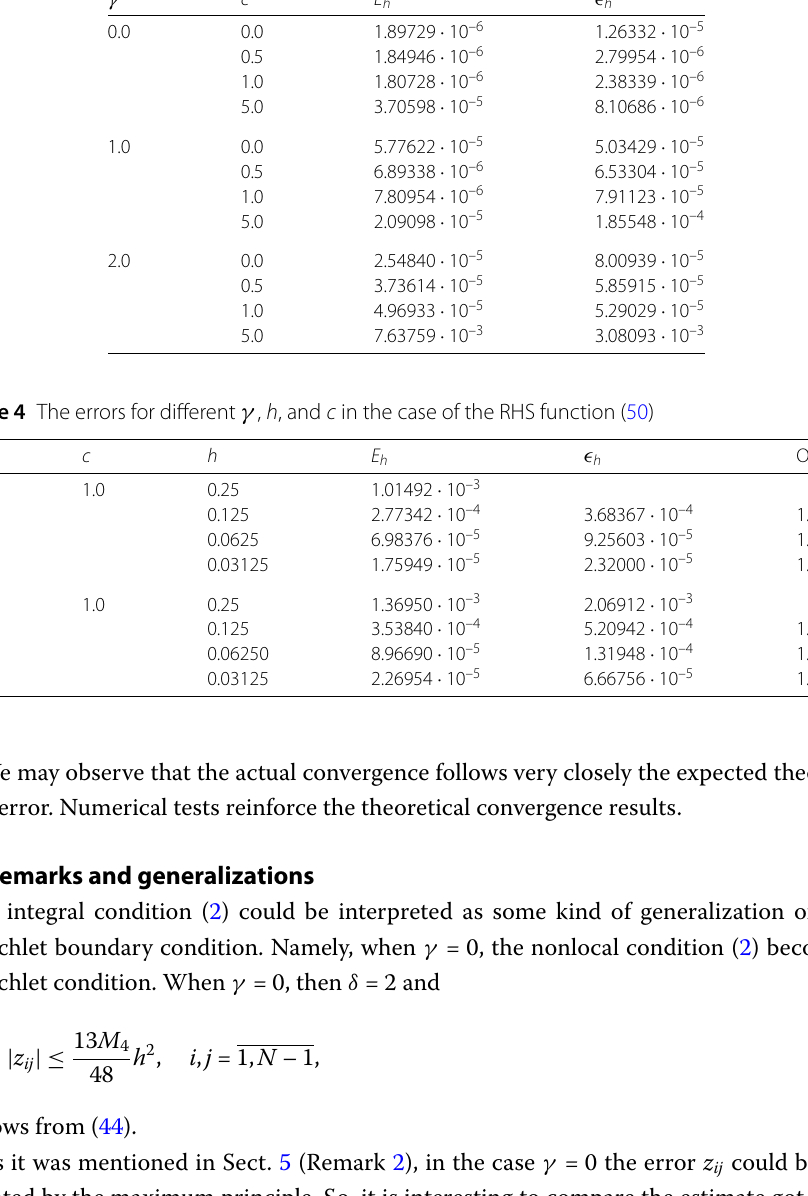
Table 3 The errors for different γ and c in the case of h = 0.01 γ c E h (cid:10) h 0.0